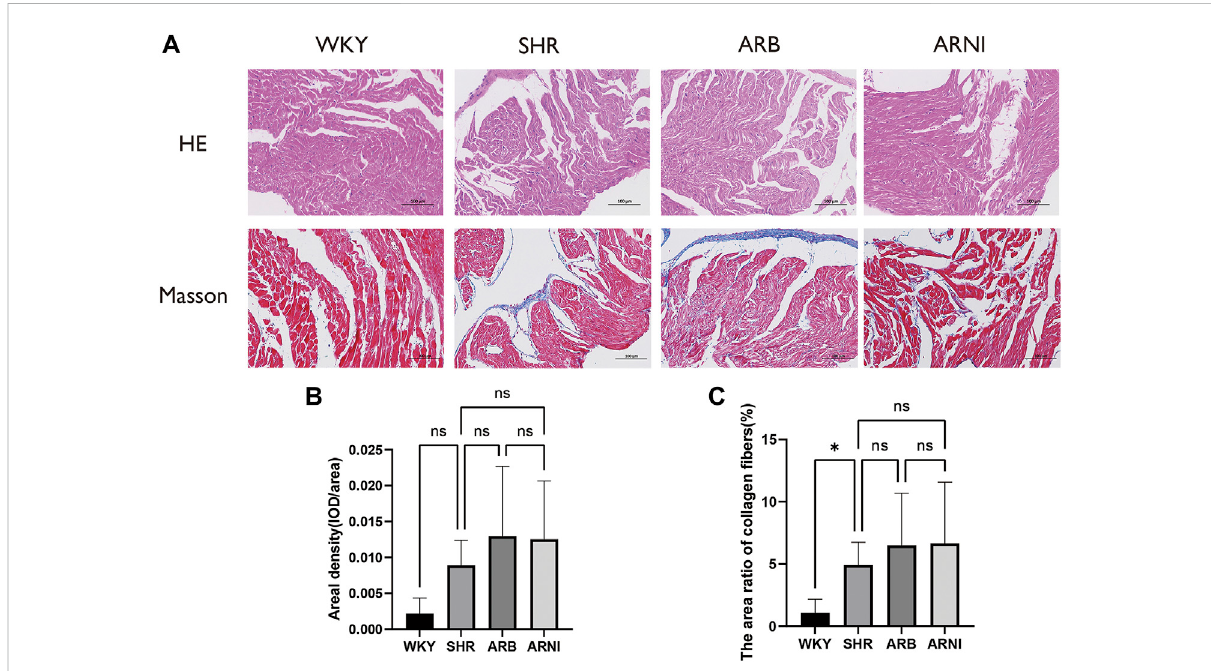
FIGURE 3 Morphology oftheleftatrium indifferentgroups. (A) The leftatriums wereharvested for H&E andMasson ’ strichrome. (B) Quantitativeanalyses ofarealdensity (IOD/area)inMasson ’ strichrome infourgroups. (C) Quantitativeanalysesofthearearatioofcollagen fi bersinMasson ’ strichrome in four groups. H&E, hematoxylin-eosin; WKY, Wistar-Kyoto; SHR, spontaneously hypertensive rat; ARB, angiotensin receptor blocker;